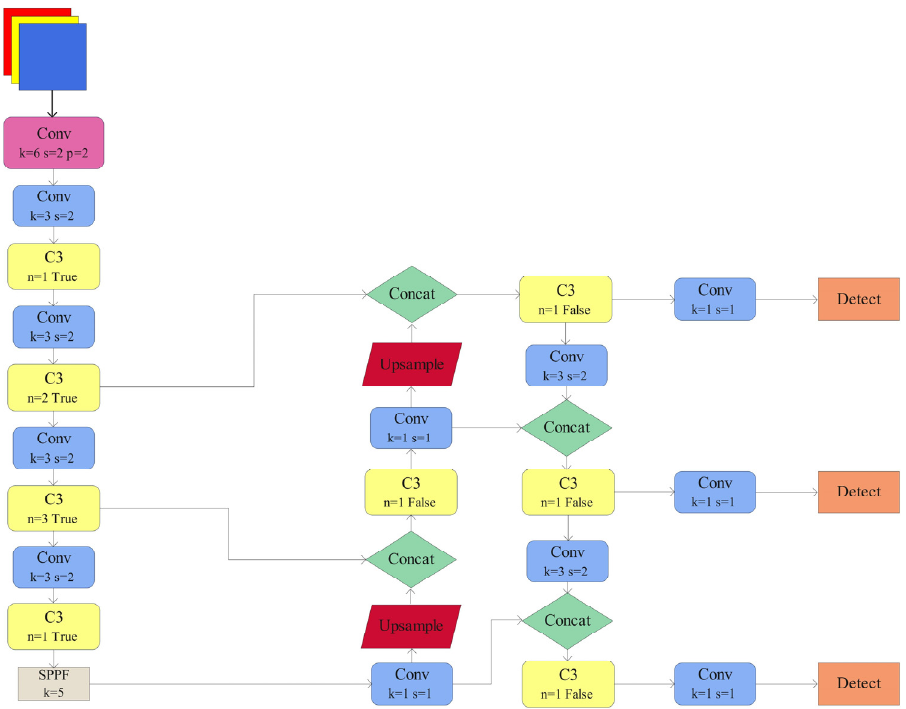
Figure 3. YOLOv5 network structure (The arrows indicate the direction of forward